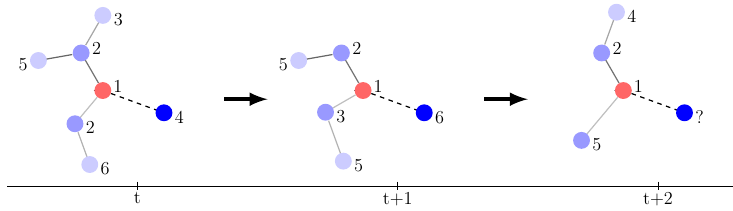
Figure 1. An example of entity prediction task on temporal knowledge